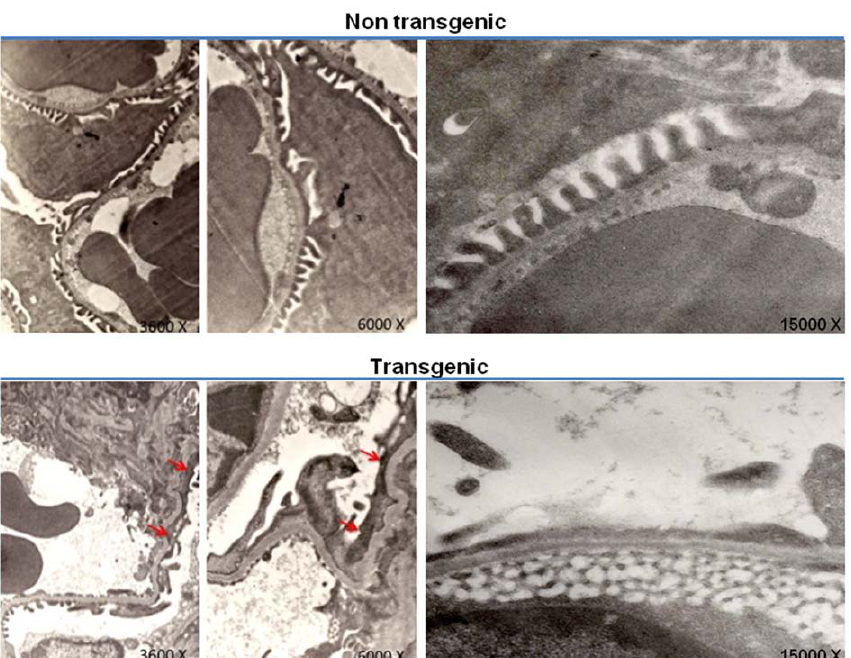
Figure 6. Ultrastructural changes in podocytes from Trpc6-HA transgenic mice. Kidney sections from 3 month old non transgenic (top panel) and transgenic (bottom panel) mice were assessed by electron microscopy. In the top panel an overview of normal mesangium and capillary loops and filtration barrier with normal foot processes is shown for the non transgenic mice (3000, 6000 and 15,000x respectively). In the bottom panel it can be observed that extensive foot process effacement of the podocytes are present in the transgenic section (red arrows) (3000, 6000 and 15,000x respectively).